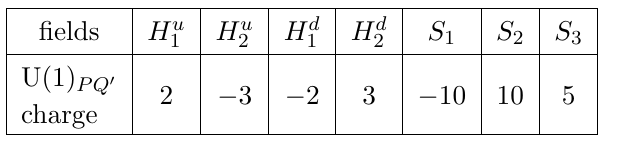
Table 4 . U(1) PQ 0 charges of the SM singlets with PQ 0 = (5 PQ